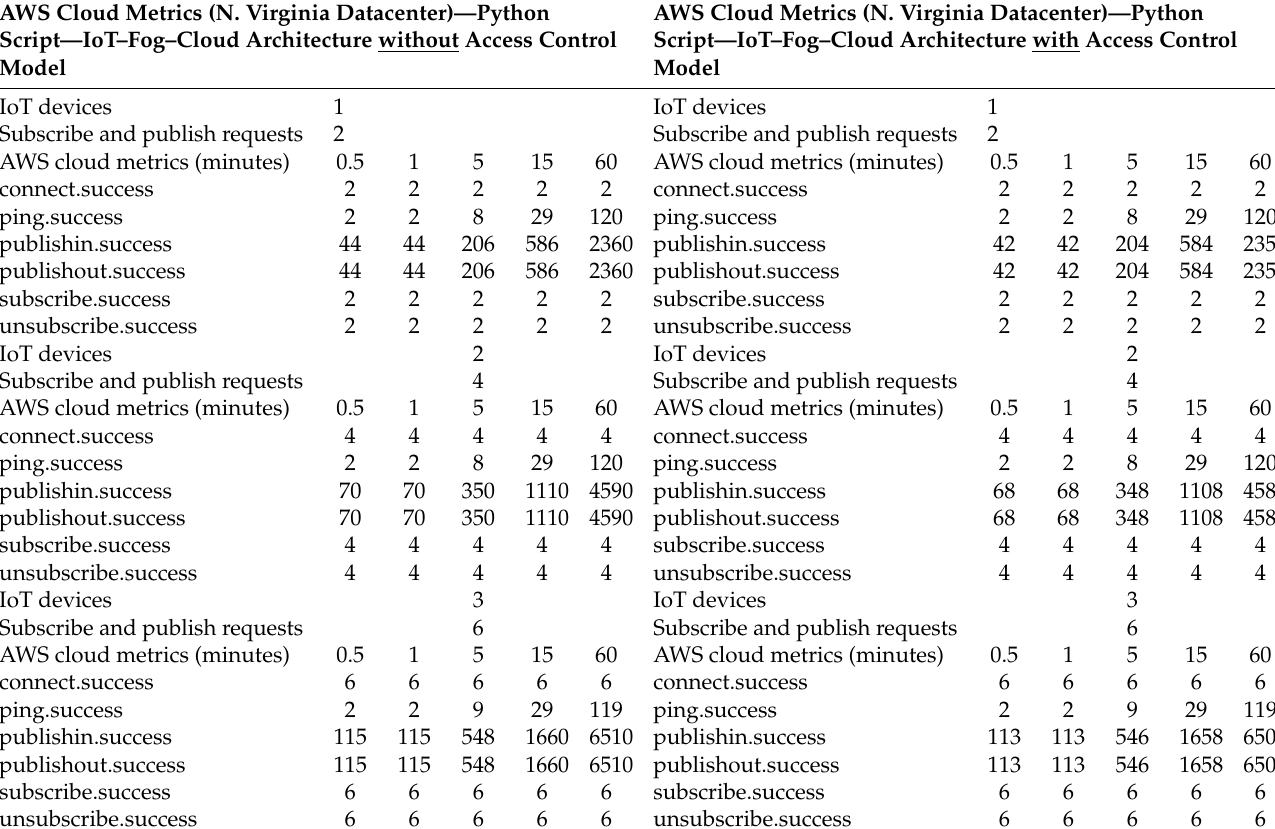
Table 4. AWS cloud metric results on N. Virginia datacenter for the IoT–Fog–Cloud architecture with the access control model versus without the access control